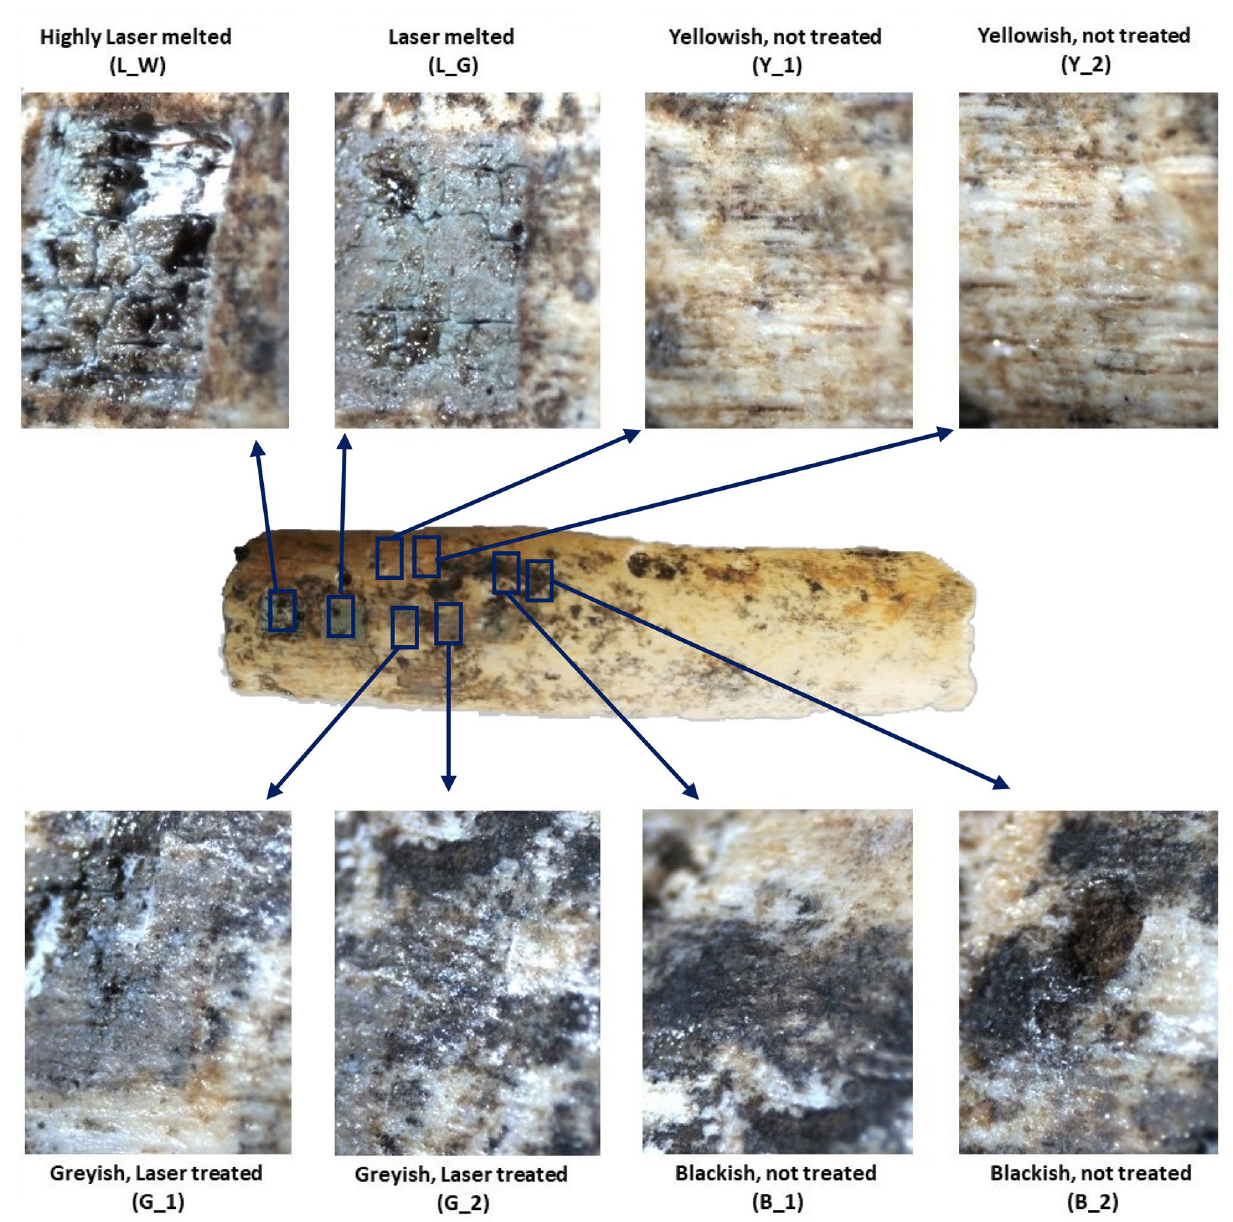
Fig. 6 Optical micrographs of the different laser-treated and non-treated bone areas where laser-induced phenomena and original surface conditions are